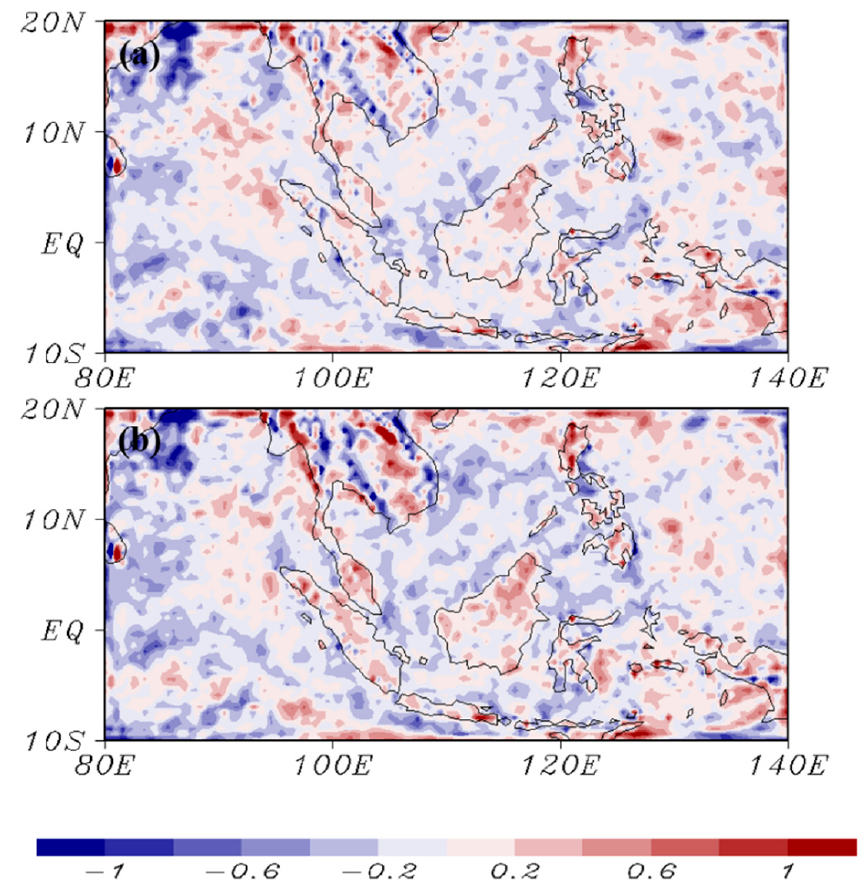
Figure 9. Difference of vertical integrated apparent moisture sink ( Q 2 ; mm/day) from 1000 hPa to 700 hPa for 96~120 h forecast based on 32 daily cases from 0000 UTC 15 May 2020 to 0000 UTC 15 June 2020 computed against ERA5 reanalysis data from ( a ) CTRL and ( b ) EXP experiments.